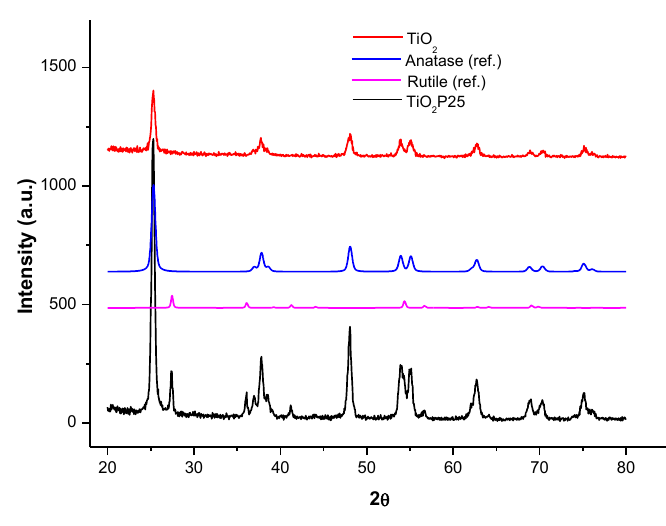
Figure 4. XRD spectra of titania supports.